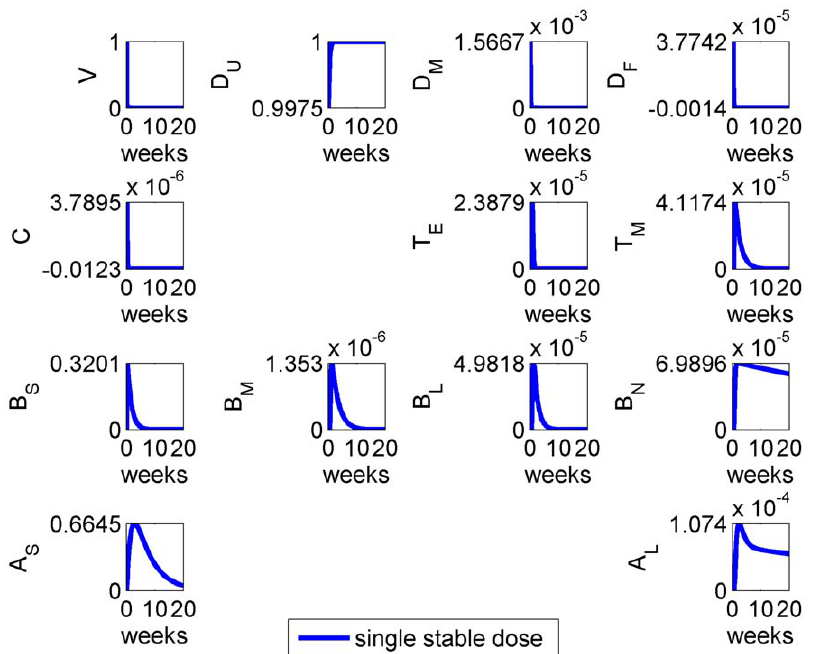
Figure 2. Model results for the system with initial vaccination at time t ~ 0 , with parameters as given in Table 2 and ‘‘stable’’ vaccine.